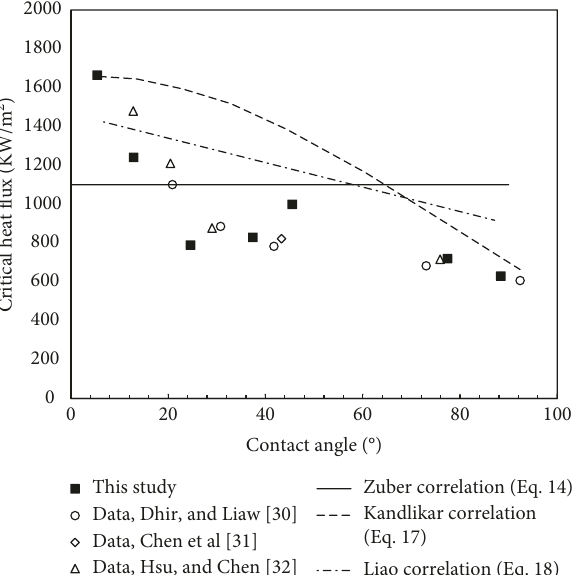
Figure 15: Critical heat flux versus contact